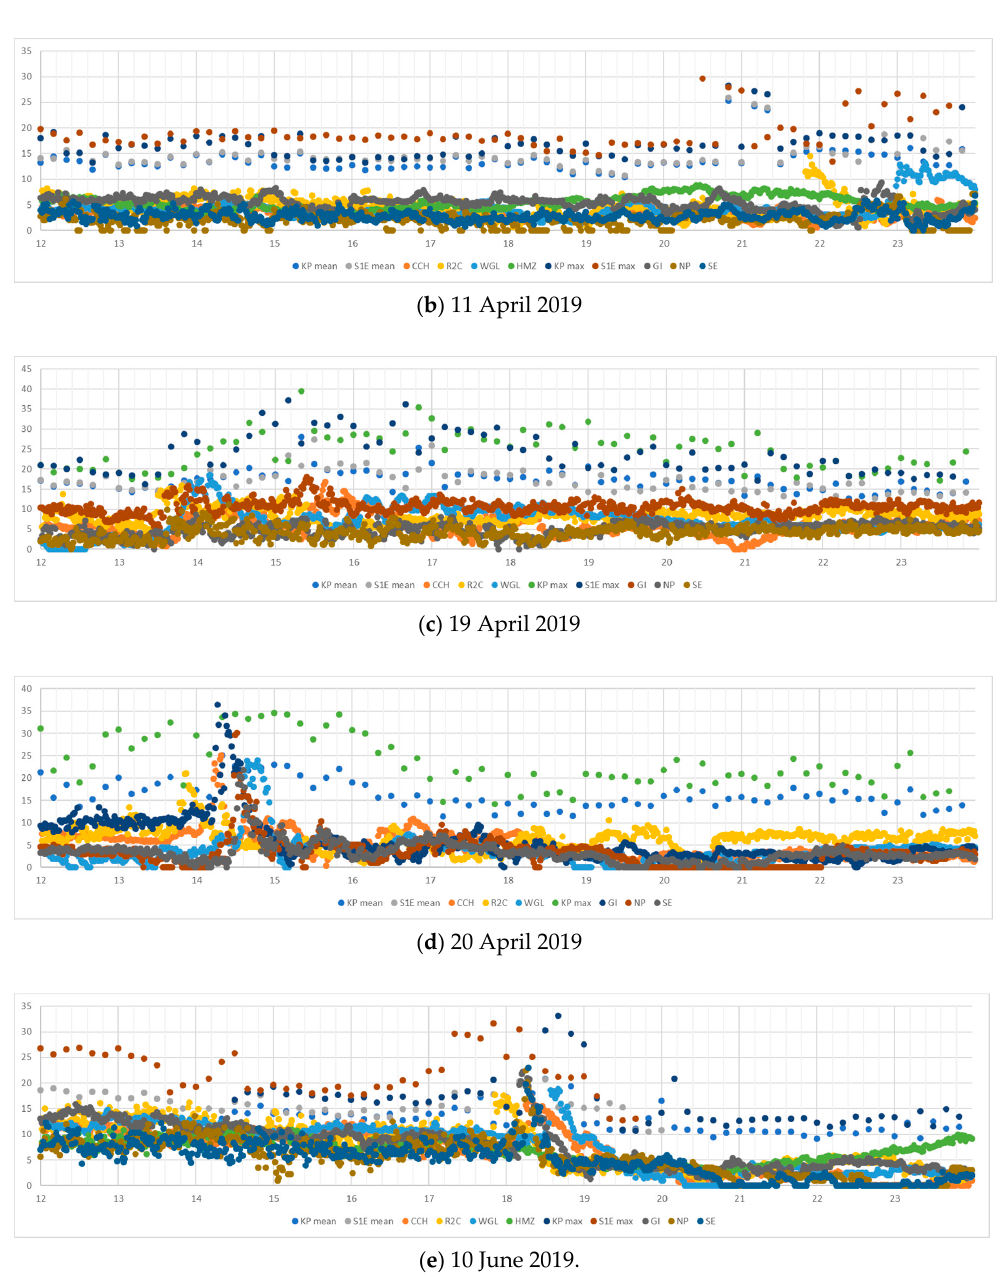
Figure 10. ( a ) The locations of the automatic weather stations with wind data (locations with